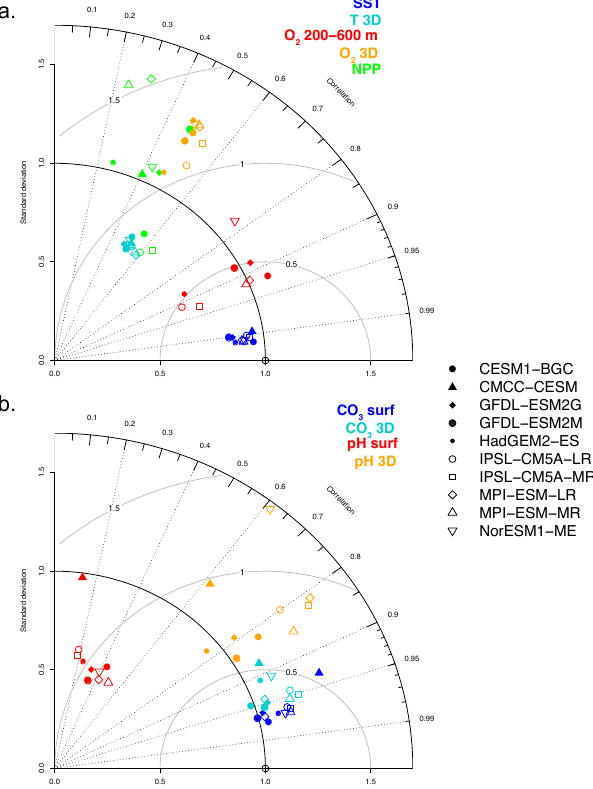
Fig. 2. Taylor diagrams showing the correspondence between annual-mean model results and observations for (a) SST, 3-D tem- perature, subsurface O 2 averaged over 200–600m, 3-D dissolved O 2 , vertically integrated NPP; and (b) surface pH, 3-D pH, surface carbonate, and 3-D carbonate ion. Data-based products are from Reynolds et al. (2008) for SST, computed using DIC and alkalin- ity from Key et al. (2004) for pH and CO 2 − , from WOA 2009 for 3 dissolved O 2 concentrations and 3-D temperature, from Behrenfeld et al. (1997) for NPP. For NPP, all coastal points (identified with a bathymetry of less than 500m) are left out. All data are from 1990– 1999 except observed NPP from 1997–2006, and O 2 concentration and 3-D temperature from WOA 2009 climatologies. The angular coordinate indicates the correlation coefficient ( R ), the radial coor- dinate shows the normalized standard deviation (stdmodel/stdobs). A model perfectly matching the observations would reside in point